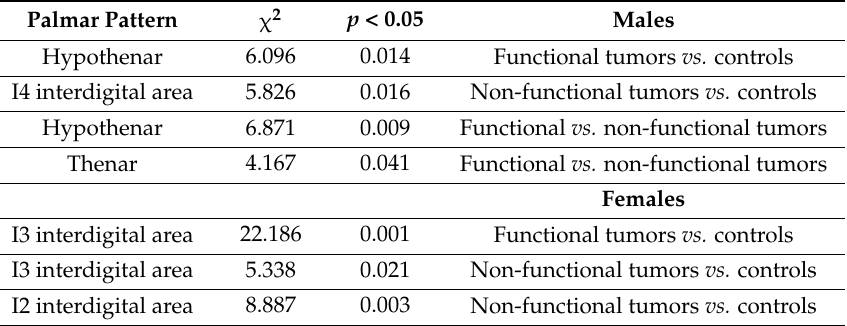
Table 5. Chi square test analysis of qualitative dermatoglyphic traits (palmar patterns) comparing groups with functional tumors, non-functional tumors and controls (statistically significant variables are